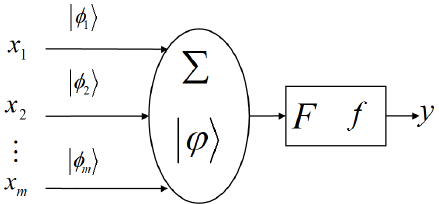
Figure 2. Diagram of quantum weighted neuron model.